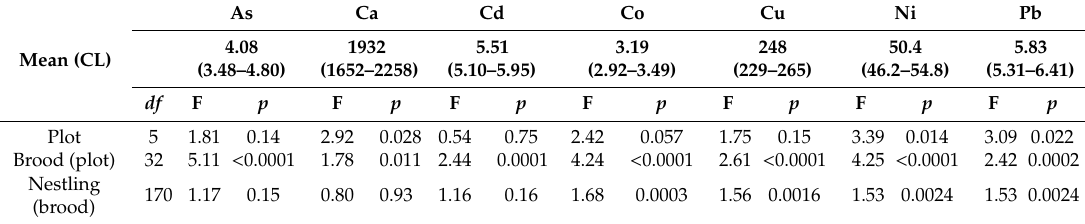
a Linear models with nested structure for age-corrected values (i.e., residuals from regression with age as an explanatory factor). F values were calculated by always using the Type I mean squares of the next lower level term as an error term. Error df = 183. Table 2. Hierarchical models a for partitioning the variation (%) in element concentrations ( µ g / g, d.m.) of feces of pied flycatcher ( Ficedula hypoleuca ) nestlings among study plots, broods, siblings within a brood and an individual nestling sampled two times within a day. N = 391 samples. Source of Variation df